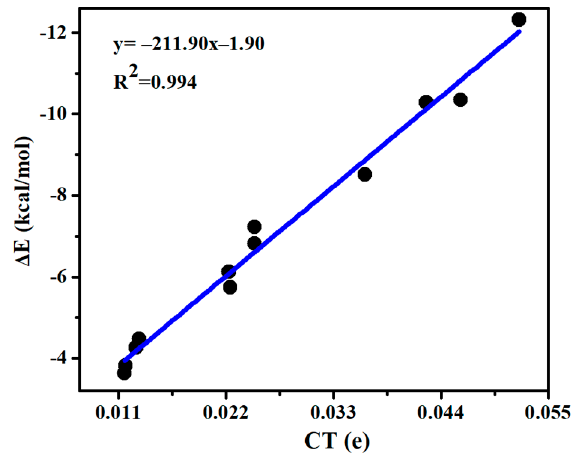
Figure 4. Interaction energy ( ∆ E) versus charge transfer (CT) in the chalcogen-bonded dyads. The interaction energy was decomposed into electrostatic (E es ), exchange (E ex ), repul- sion (E rep ), polarization (E pol ) and dispersion energies (E disp ), collected in Table 4. The total interaction energy obtained with GAMESS program is almost equal to that with Gaussian program. Among the three attractive terms (E es , E pol , and E disp ), E es is largest, confirming that electrostatic interaction is dominant. This conclusion is further confirmed by the linear relationship between the total interaction energy and the electrostatic interaction (Figure S4). No linear relationship is present between the total interaction energy and the other attractive terms. Politzer and co-authors explained most σ -hole interactions by means of Coulombic interactions and concluded that charge transfer is an extreme form of polarization [45,46]. However, the interaction energy of chalcogen bond displays a good linear relationship with the charge transfer but not with polarization energy. Both E pol and E disp are comparable since the latter corresponds to 50–90% of the former. Table 4. Electrostatic (E es ), exchange (E ex ), repulsion (E r ep ), polarization (E pol ), and dispersion (E disp ) energies in the chalcogen-bonded dyads, all in kcal/mol. E es E ex E rep E pol E disp E